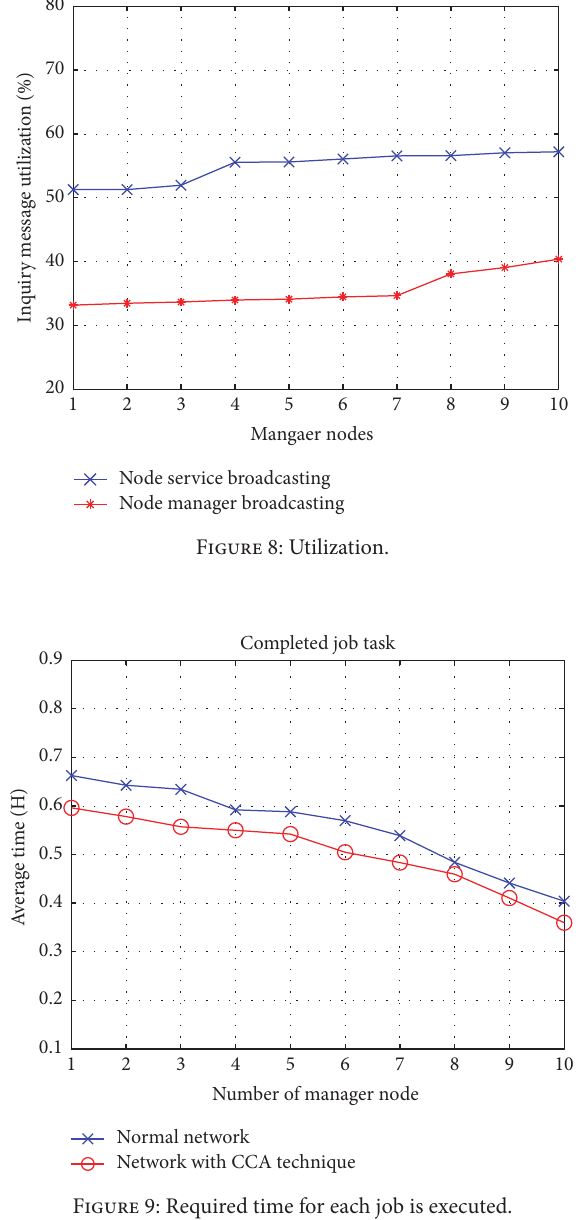
Figure 9: Required time for each job is executed.